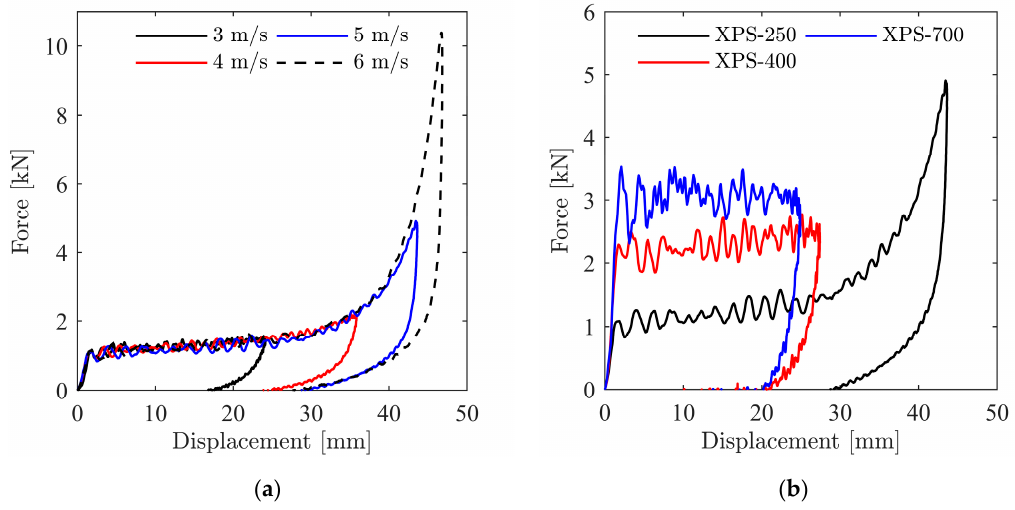
Figure 3. Force-displacement curves for (a) XPS 250 at four impact velocities and (b) comparison of the three XPS densities at 5 m/s impact velocity.